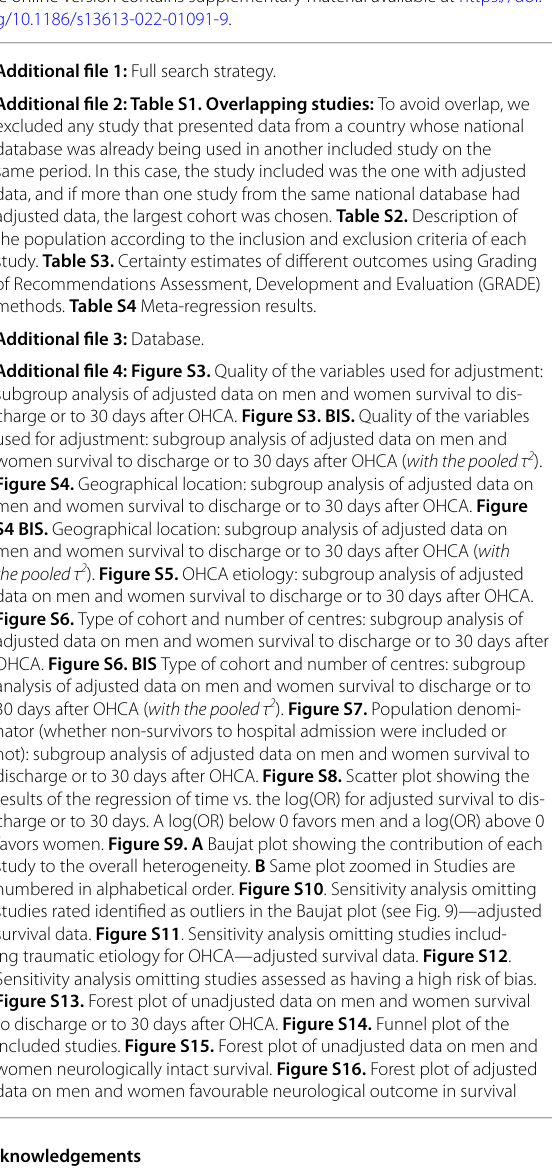
Figure S13. Forest plot of unadjusted data on men and women survival to discharge or to 30 days after OHCA. Figure S14. Funnel plot of the included studies. Figure S15. Forest plot of unadjusted data on men and women neurologically intact survival. Figure S16. Forest plot of